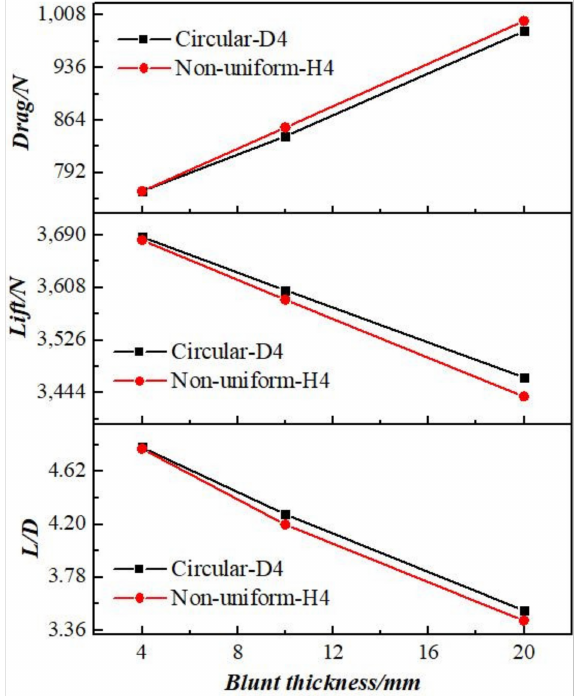
Figure 15. Aerodynamic performance force of the two blunt profiles’ thickness (angle of attack: 2